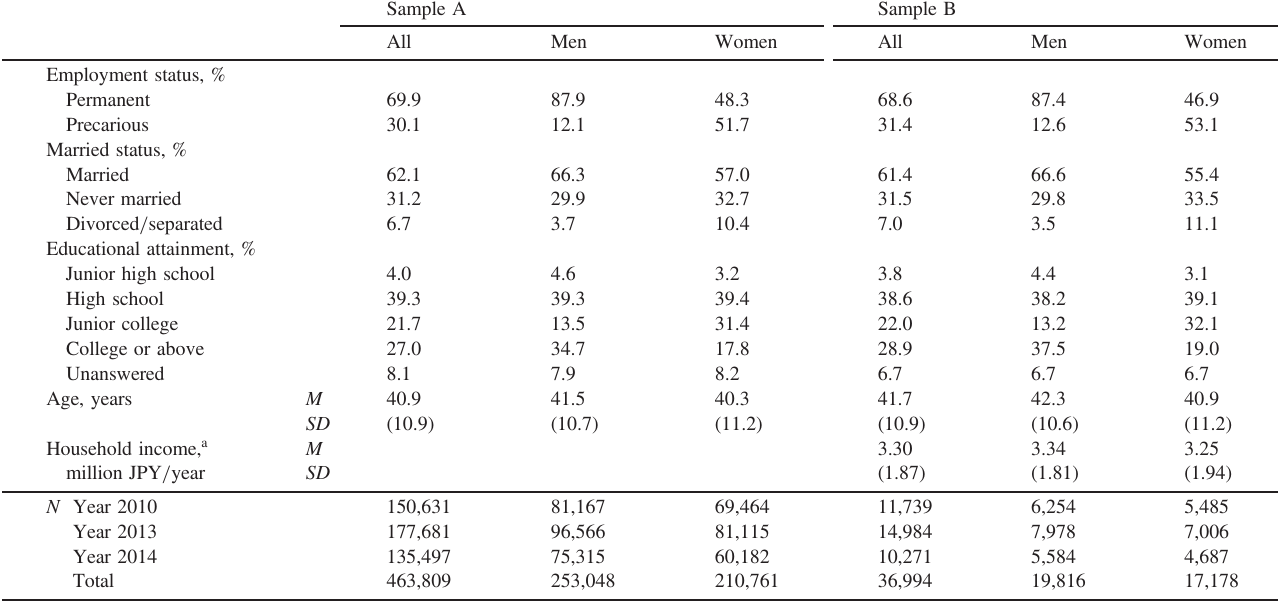
Table 1. Key features of